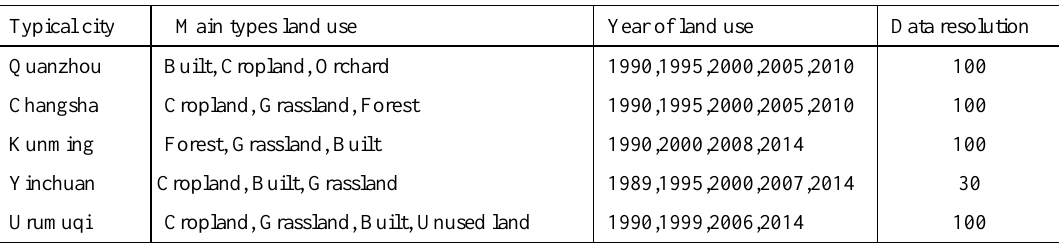
Tab. 3 The characteristics of typical city land use